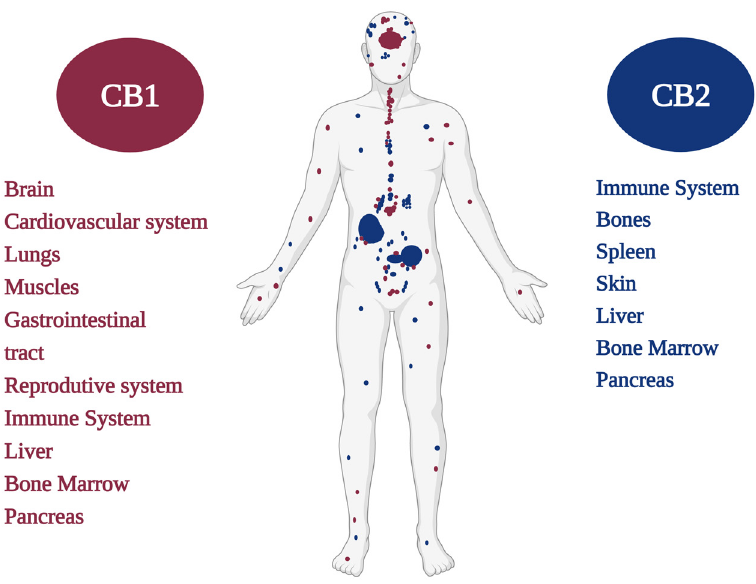
Figure 1. CB1 and CB2 cannabinoid receptors and their distribution in the human body.